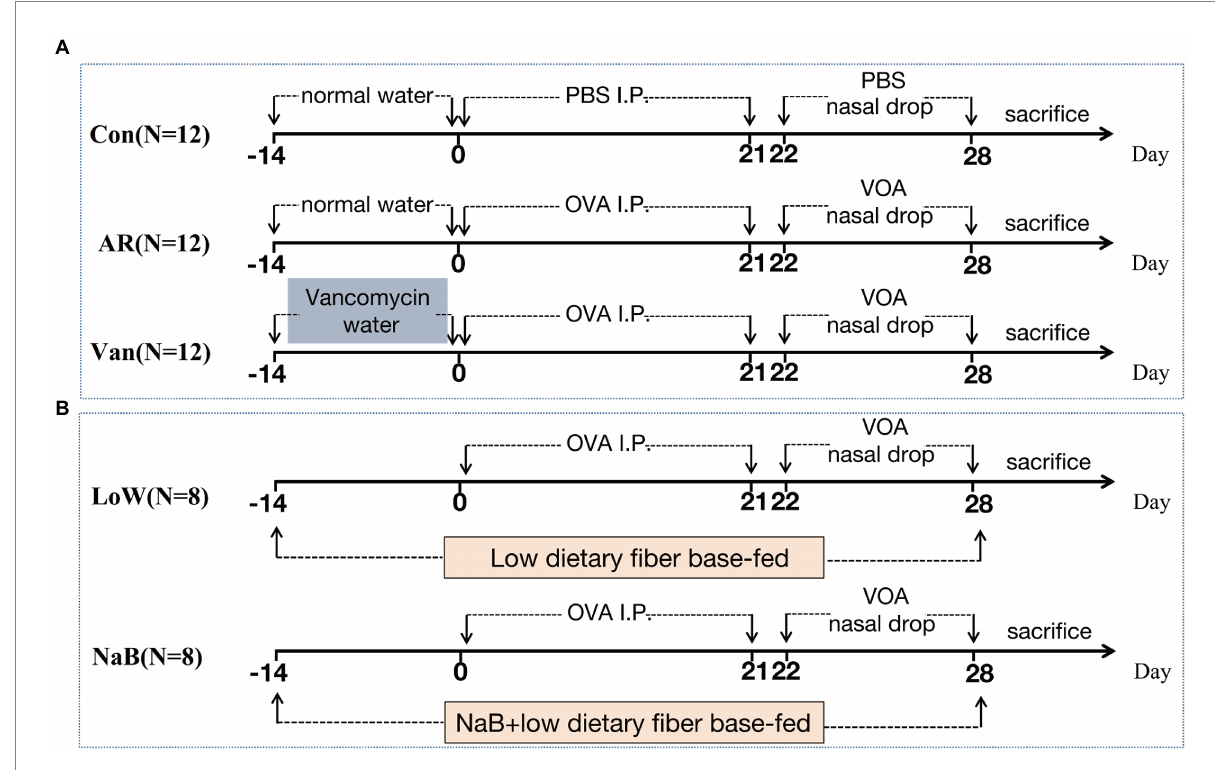
FIGURE 1 The protocol of treatment of mice in each group. (A) Establishment of Vancomycin-induced gut microbiota dysbiosis AR model. (B) Establishment of AR mice model fed a low dietary fiber basal diet or Sodium Butyrate